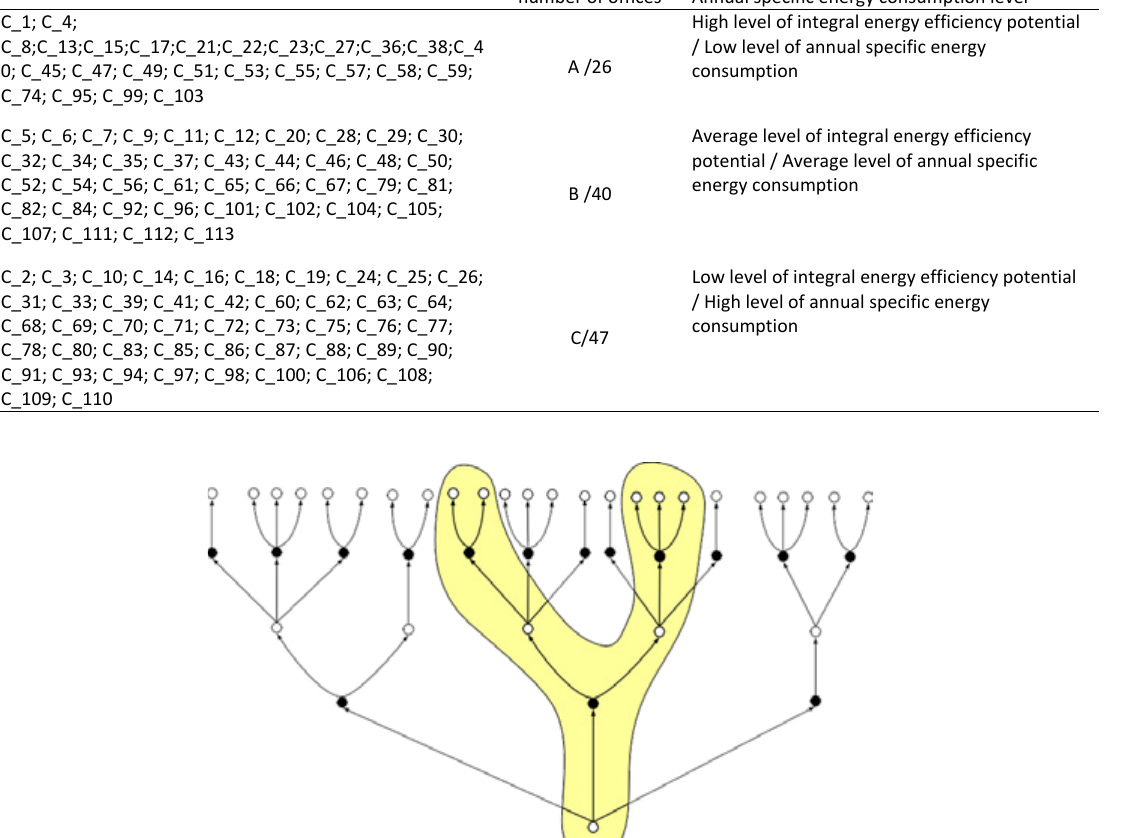
Fig. 5: Fuzzy hierarchical situation-evidence network and the ABC-principle output sub-graph of university offices